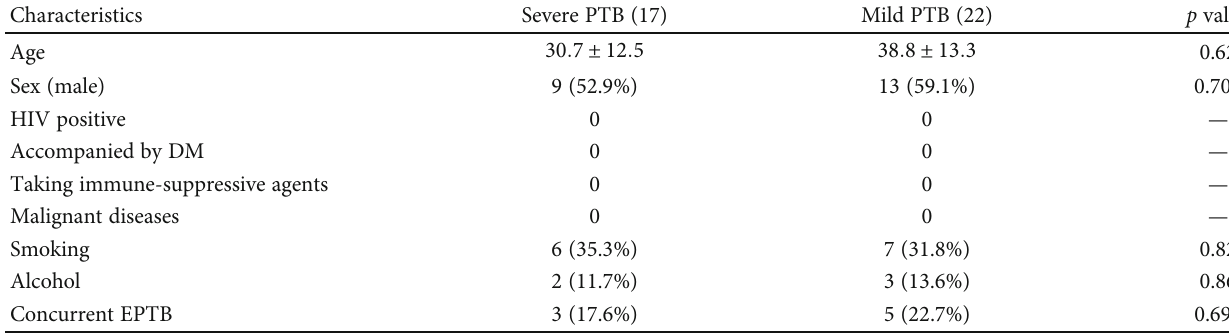
Table 3: Characteristics of patients with